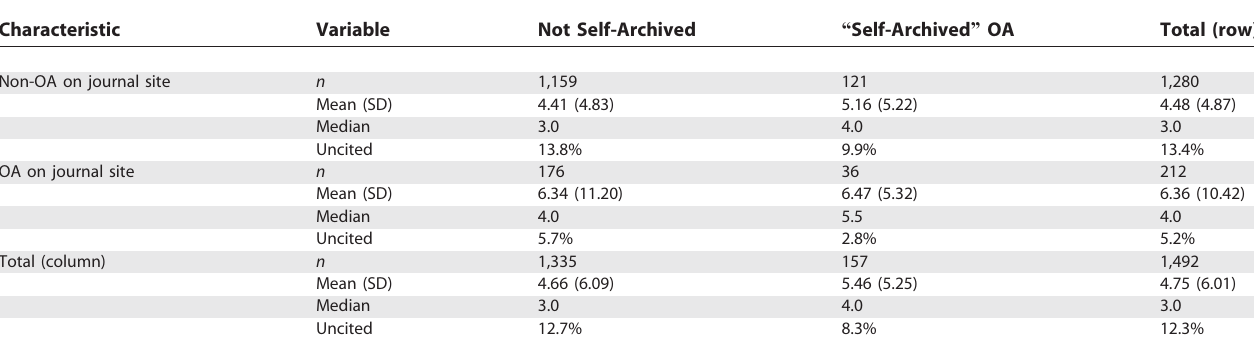
Table 4. Secondary Analysis with ‘‘ Self-Archived ’’ (Openly Accessible Articles Found on the Authors’ Homepages, in Institutional Repositories, or Elsewhere on the Internet) as Separate Subgroup (October 2005 Analysis, 10–16 mo after Publication) Characteristic